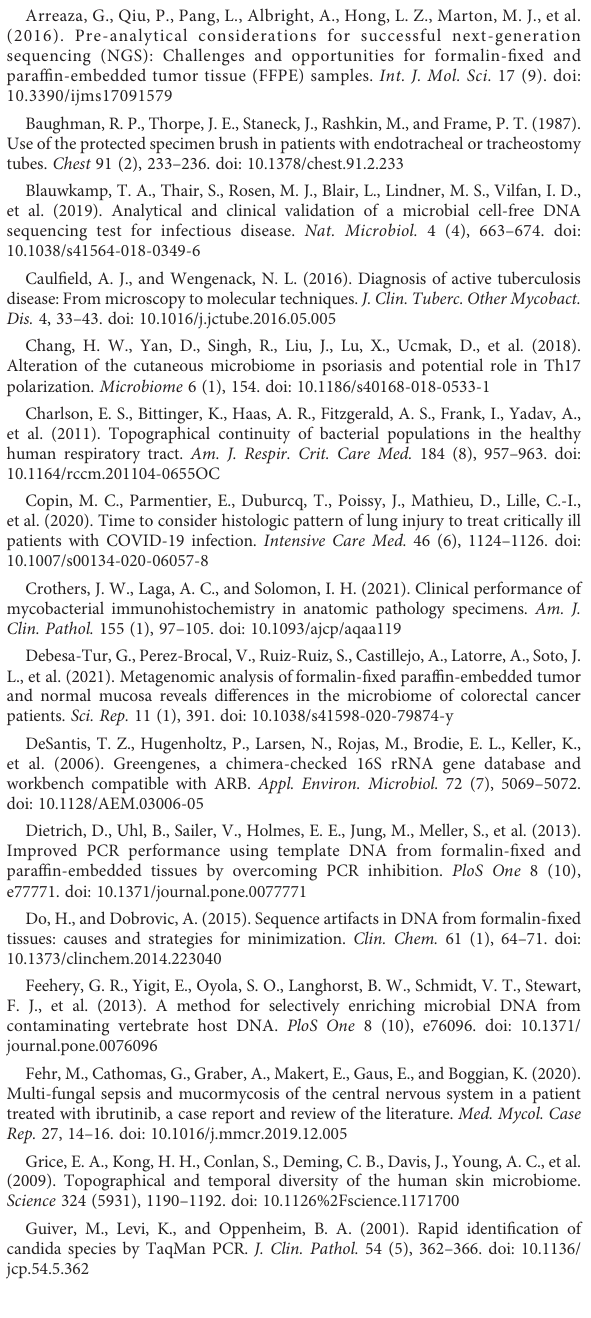
indicated step in the analysis pipeline. Plots of (A, B) : Box shows range from fi rst to third quartile and median, whiskers display minimum and maximum. (C) Genetic origin of sequence information interpreted from read mapping to the human genome GRCh37 (hg19) or taxonomic pro fi ling of non-human reads. Reads, which could not be assigned to human, bacteria or viruses, are labeled as unidenti fi ed. Positive, samples positive for bacterial species; Negative, samples without bacterial species, as determined by metagenomics analysis. Bar graph displays median and standard deviation for all 73 (29 positive and 44 negative) samples. Grey